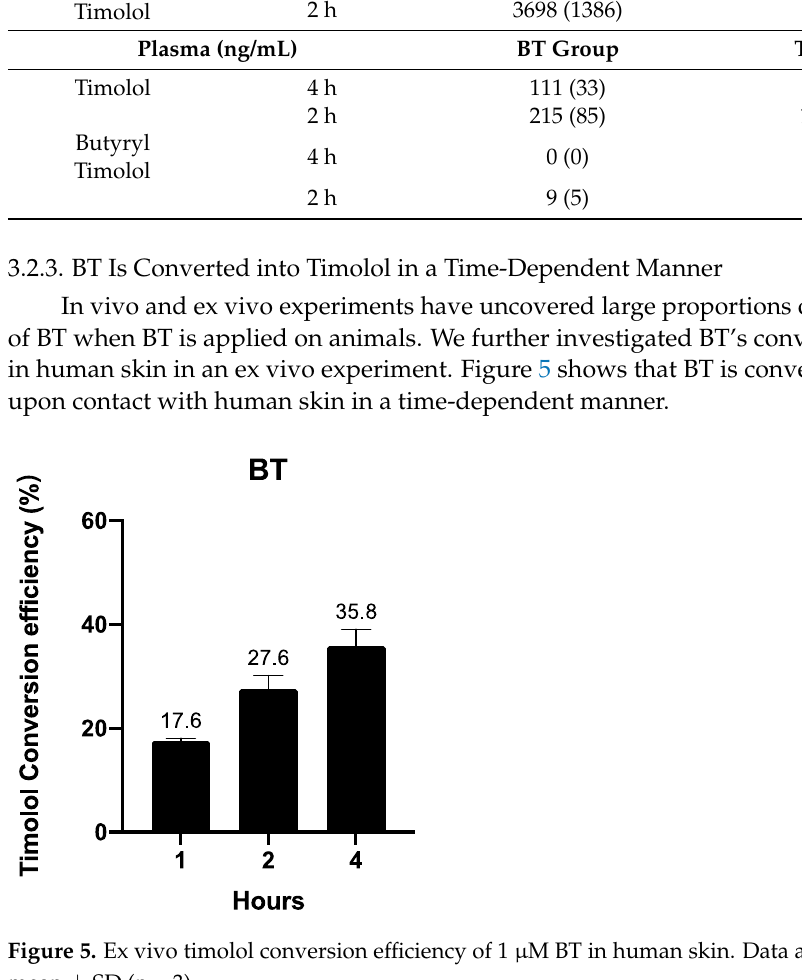
Figure 6. IH cytotoxicity assay. Cell viability tended to gradually reduce as higher concentrations of TM and BT. 4. Discussion In this study, we found that BT, as a prodrug of TM, enhances timolol permeation and skin retention, facilitating timolol to pass through the skin and reach the deeper cor- ners of the tumor while maintaining low systemic absorption. By employing ex vivo and in vivo animal and human tissue experiments, we have also demonstrated that BT is con- verted to timolol in the skin. BT’s biocompatibility in IH remains unchanged from that of TM. A prodrug is a chemical modification of the parent drug that is usually activated by a different environment from its parent drug (i.e., pH, oxidation–reduction, enzyme, etc.,). The physiological barrier to be penetrated by transdermal drug delivery is the skin surface (stratum corneum, SC), and the drug delivery route through the SC is via the intercellular lipid matrix. Therefore, better lipid solubility of transdermally administered drugs facili- tates their passage through the SC [17]. Although SCs facilitate the penetration of lipo- philic drugs, the epidermis and dermis are hydrophilic and thus act as a barrier to further 0